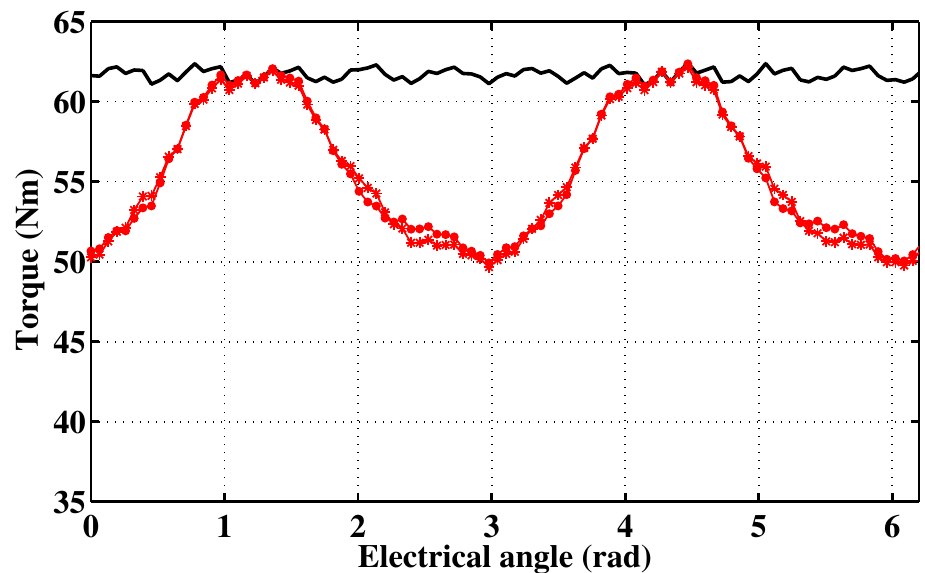
Figure 18. Torque-angle characteristics for the coil rated current rms value of 14 A in the case of the proposed armature winding arrangement. Legend: (red dots) faulty scenario corresponding to the case where a branch of a single coil of N H is passive, (red stars) faulty scenario correspond- ing to the case where a branch of two series connected coils of N L turns each is passive, (black) healthy operation.